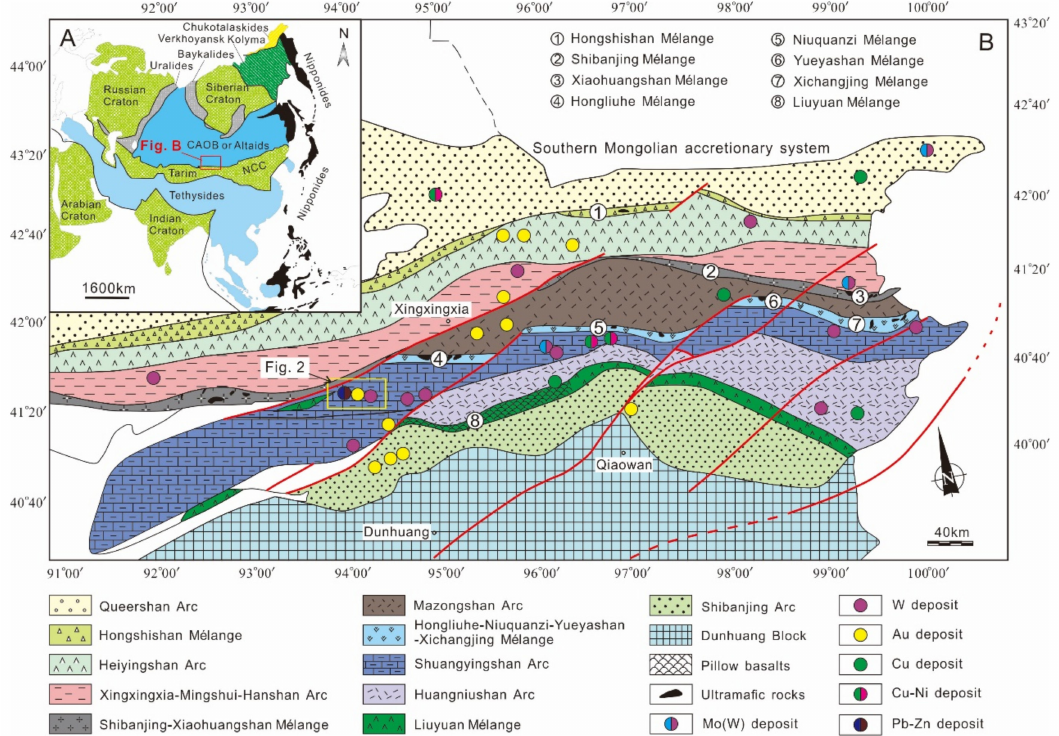
Figure 1. ( A ) Location of the study area within the Central Asian Orogenic Belt (modified after [24]). Abbreviations: CAOB= Central Asian orogenic belt, NCC = North China Craton; ( B ) Simplified tectonic map of the Beishan orogenic collage and its adjacent area showing the tectonic subdivisions (modified after